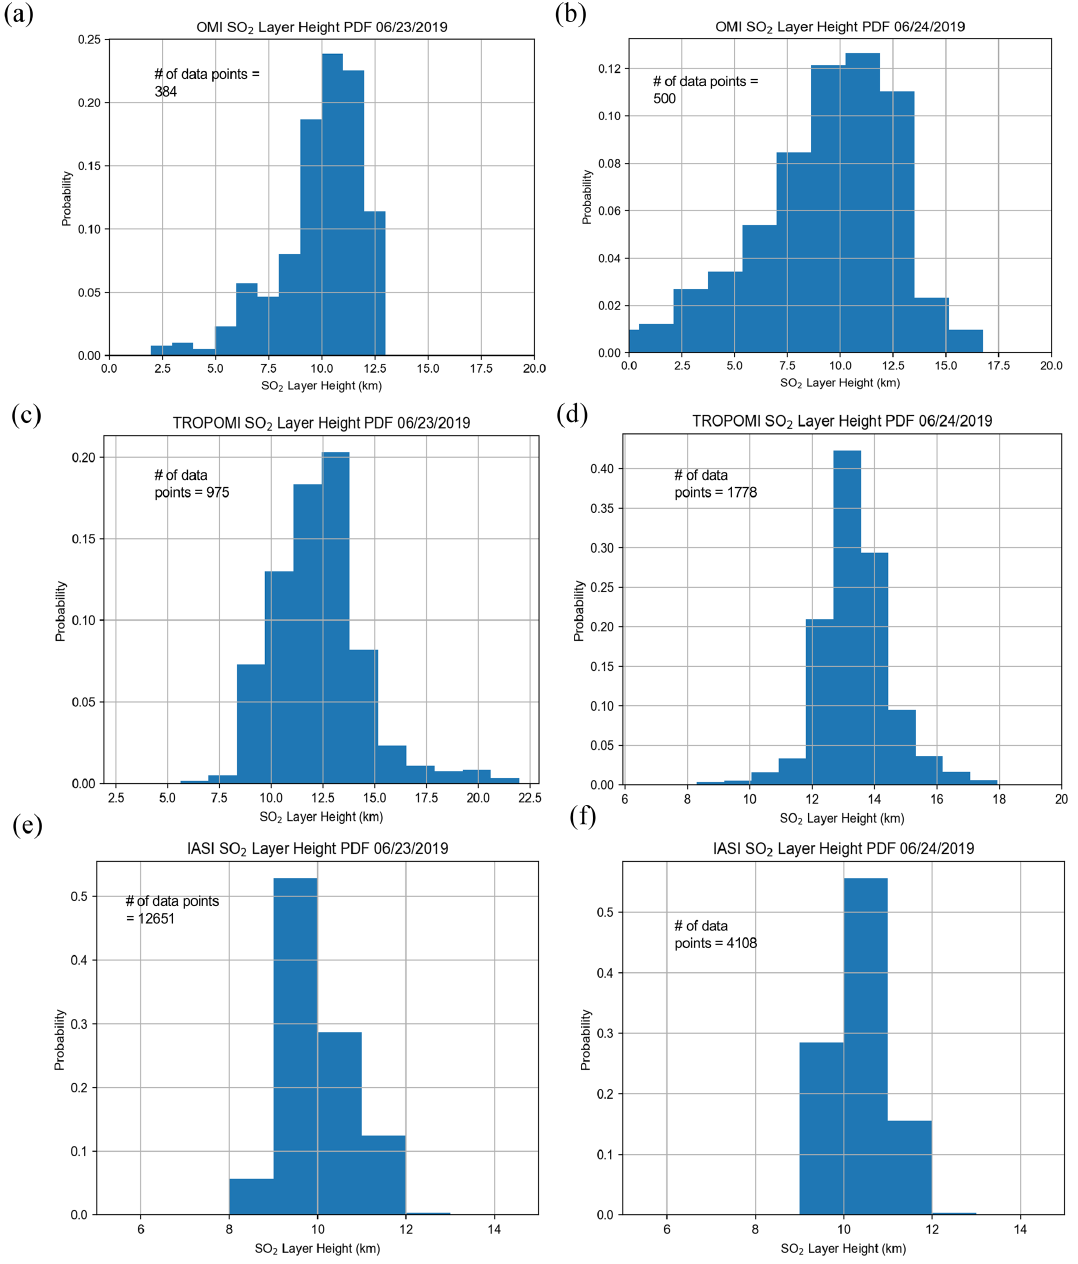
Figure 10. Probability histograms of SO 2 layer height retrievals for (a, b) OMI, (c, d) , TROPOMI, and (e, f) IASI on 23 June 2019 (a, c, e) and 24 June 2019 (b, d, f) . Only pixels with an SO 2 column amount greater than 30DU are included. These plots correspond to the results plotted in Fig.